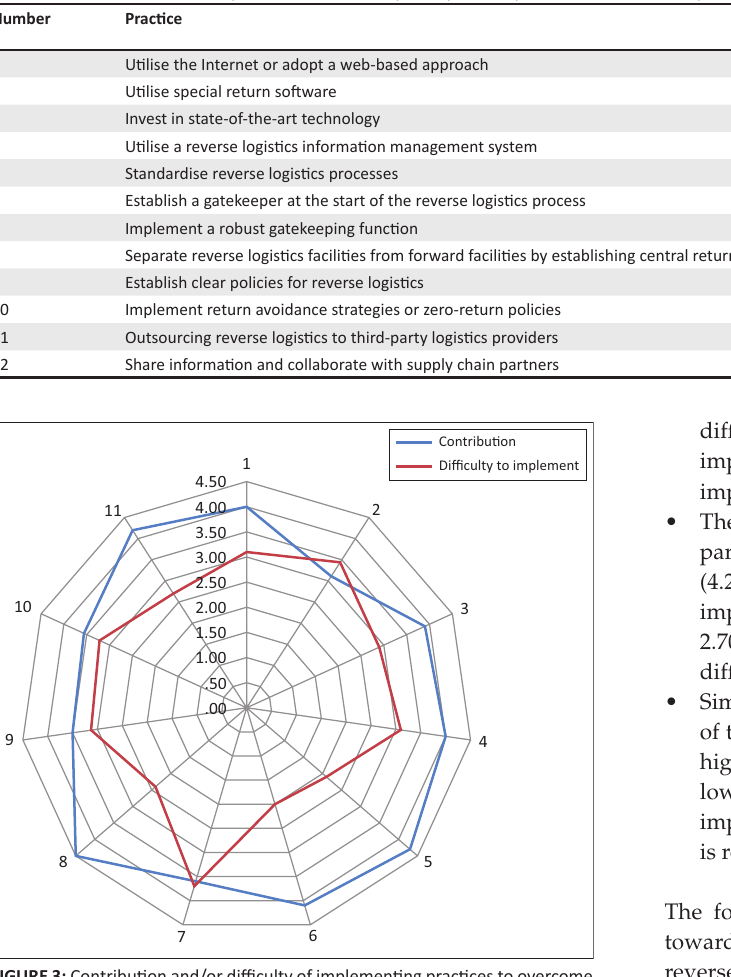
FIGURE 3: Contribution and/or difficulty of implementing practices to overcome operational barriers in reverse